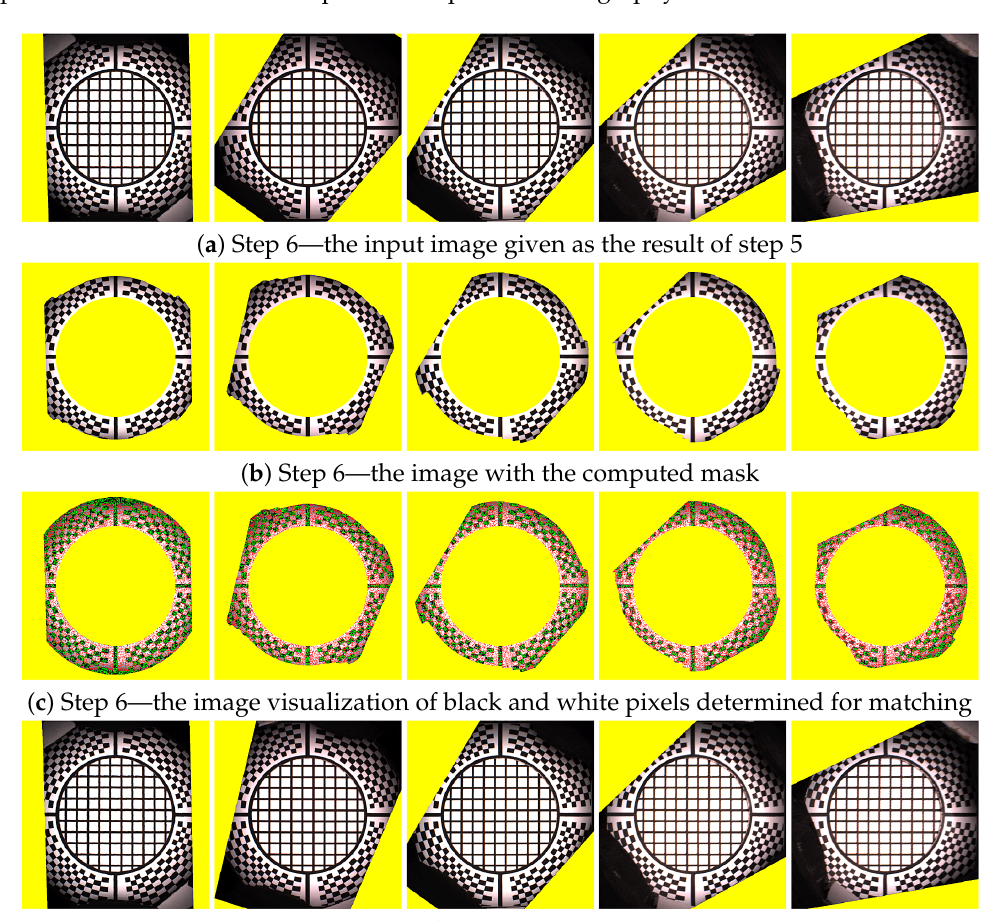
Figure 20. Step 6 of the algorithm. ( a ) Input image; ( b ) mask over the input image; ( c ) visualization of black/white classification of the masked input image by red and green marks; ( d ) the images from the homography computed by gradient descent